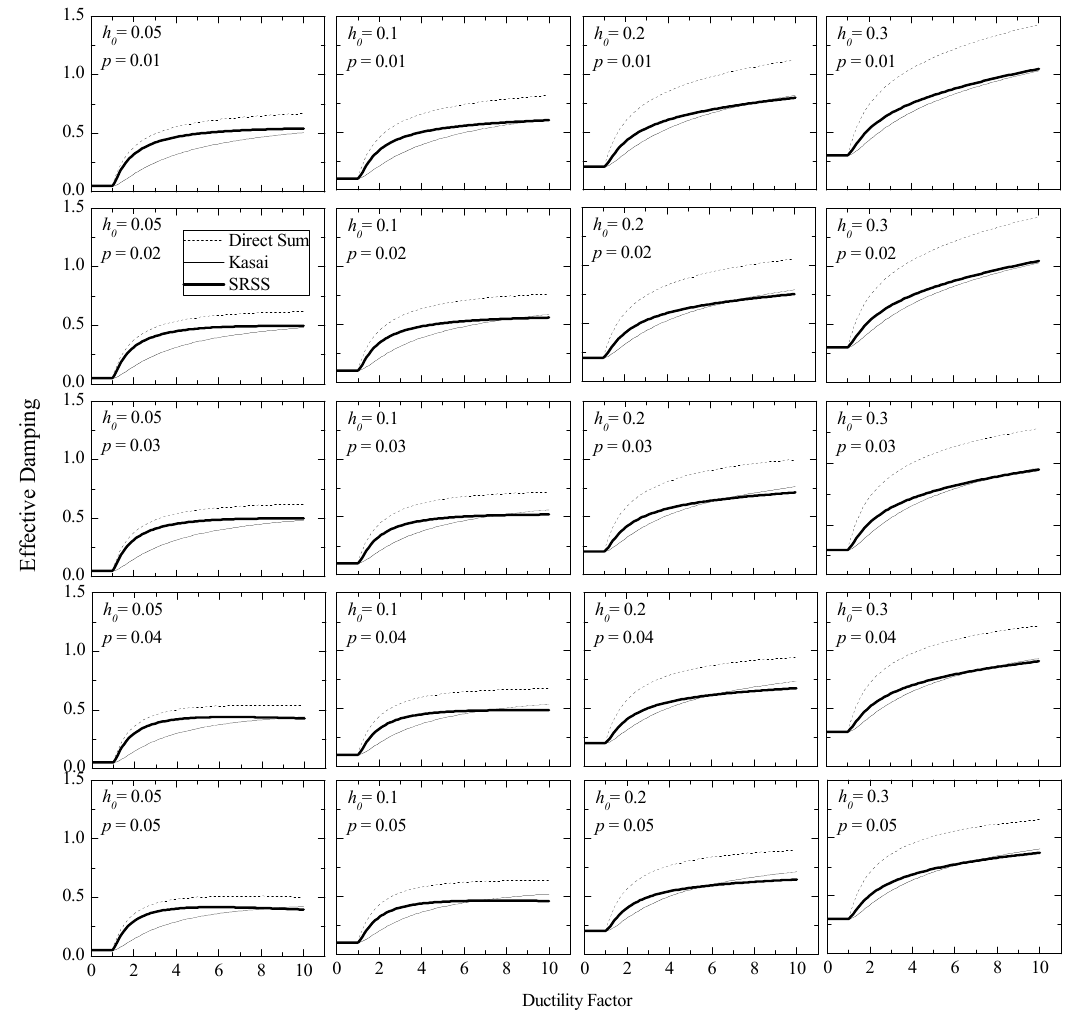
Figure 2. Comparison of different procedures to estimate the effective damping